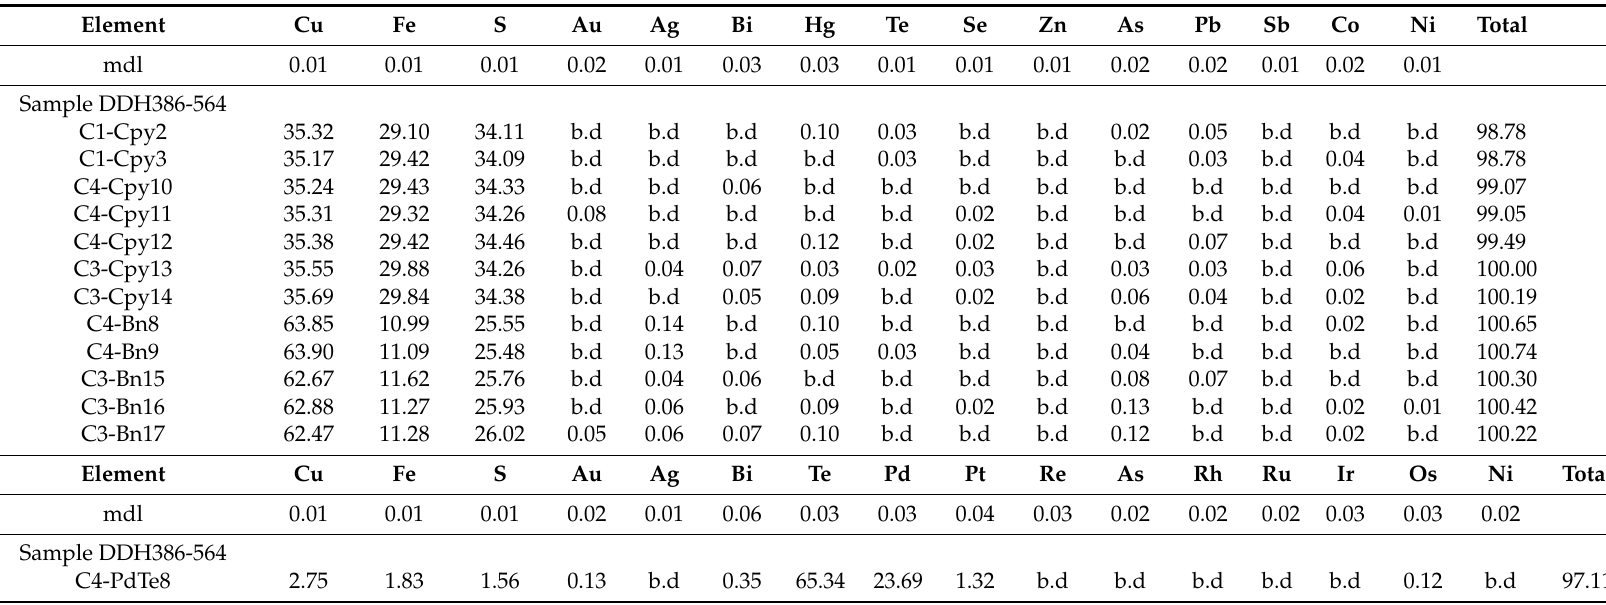
Table 1. Summary of representative electron microprobe analyses (EMPA) of chalcopyrite and bornite from the Rio Blanco deposit in (wt %). mdl = Minimum detection limits in wt %. b.d = below